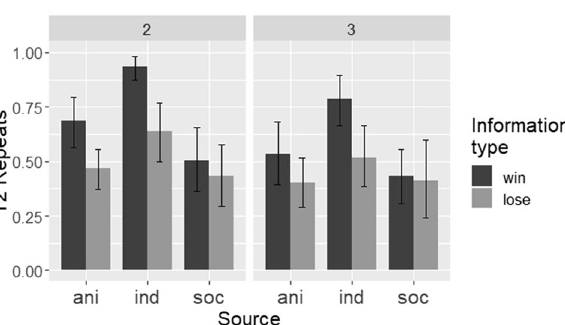
Figure 4. Non-task-proficient monkeys’ performance (as measured by T2 repeats), by source, information type, and array size. Bars show means of by-participant means, and error bars show bootstrapped 95% confidence intervals. ani animated cue, ind individual, soc